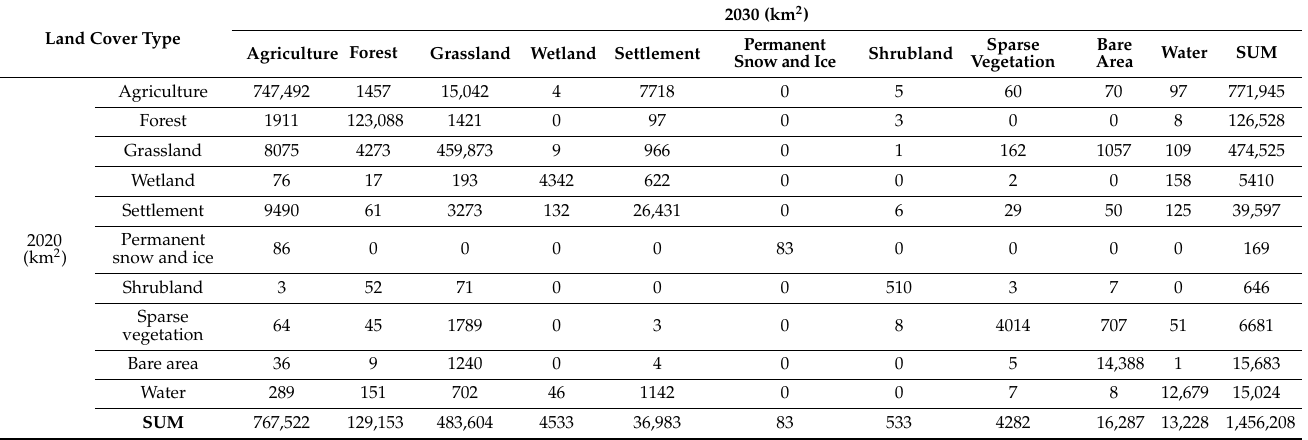
Table A2. Area transfer matrix between land cover in 2020 and land cover in